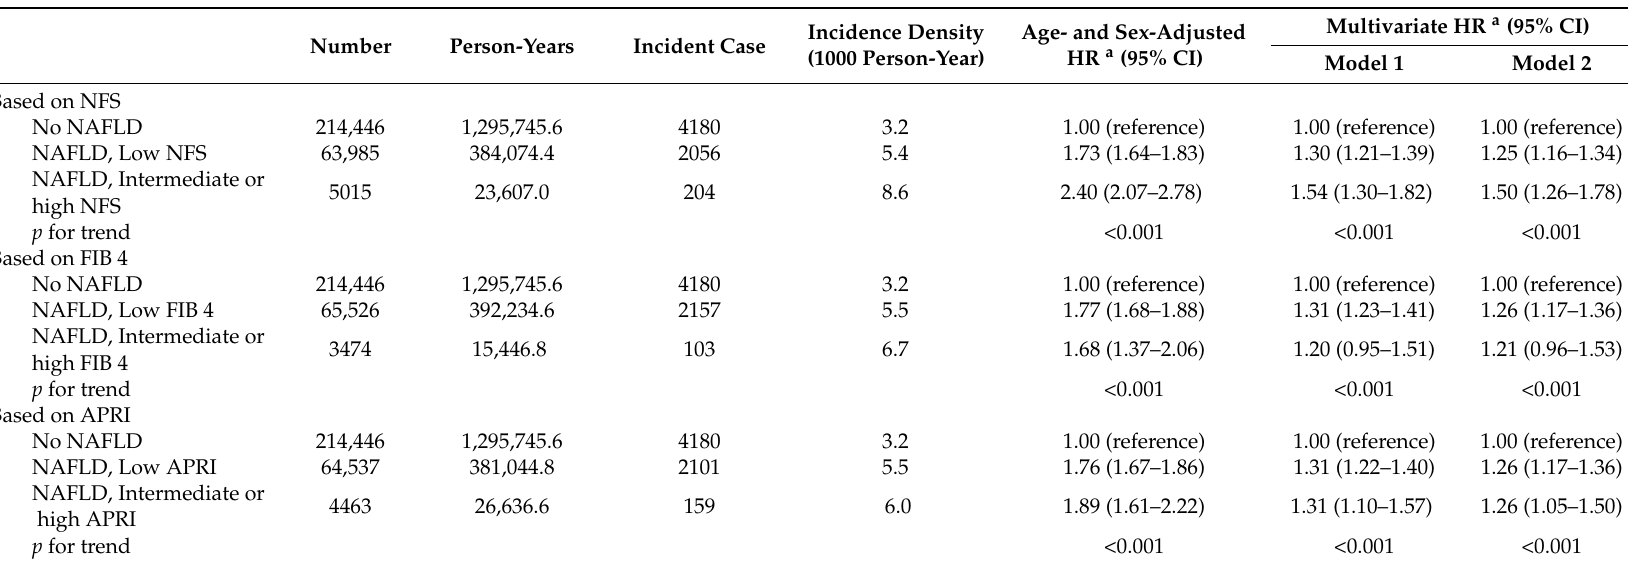
Table 3. The associations between nonalcoholic fatty liver disease (NAFLD) and its severity based on non-invasive fibrosis markers and the development of